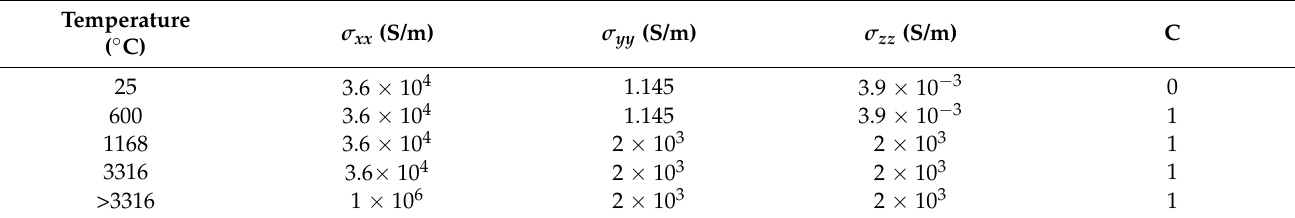
Table 2. Electrical parameters of the composites